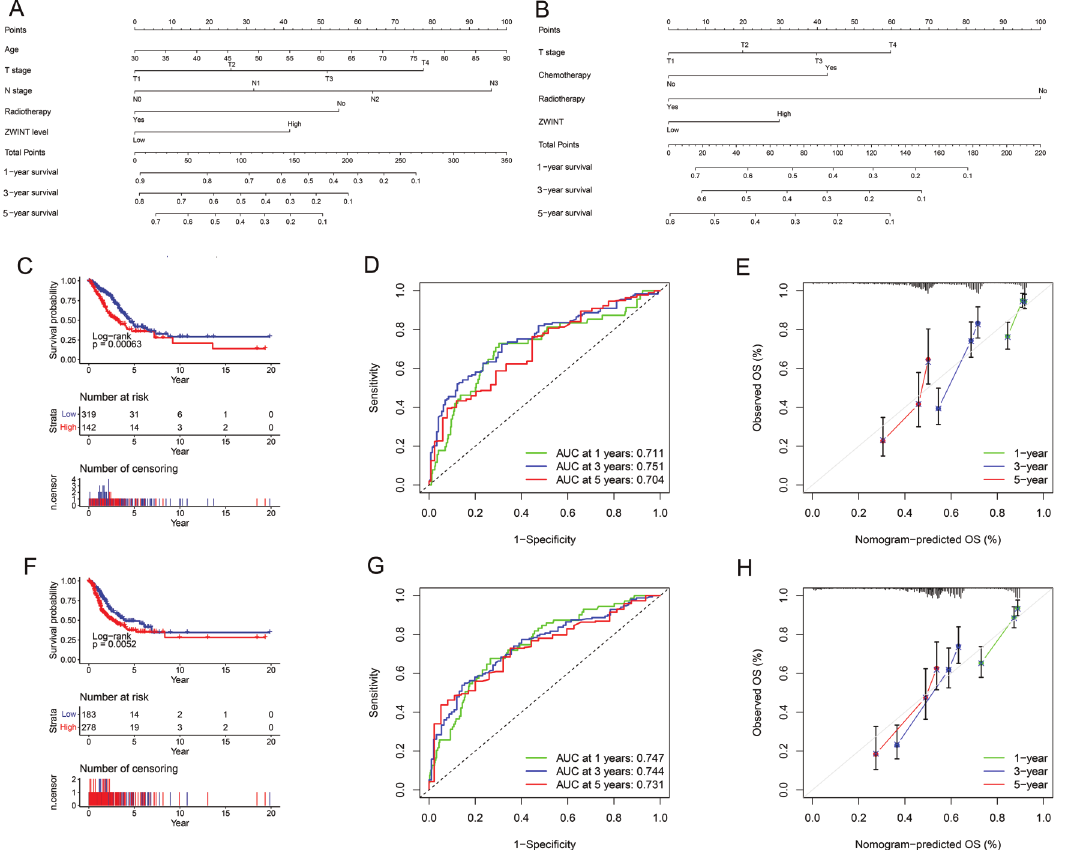
Figure 5 - Nomogram of the association between ZWINT expression level and OS (A) and PFS (B). (C). Kaplan–Meier survival curve depicting the OS of patients with different ZWINTexpression levels. (D). Time-dependent ROC curve of OS. (E). Calibration curve of OS. (F). Kaplan–Meier survival curve depicting the PFS of patients with different ZWINTexpression levels. (G). Time-dependent ROC curve of PFS. (H). Calibration curve of PFS.